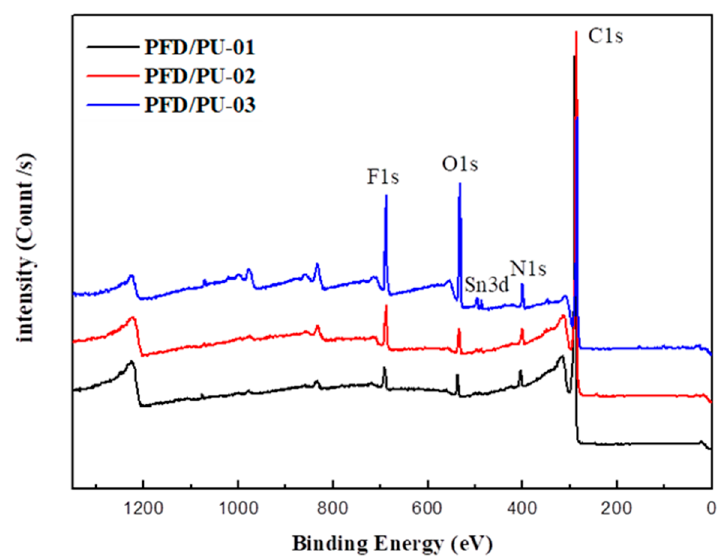
Figure 9. XPS survey spectra of PFD/PUs.